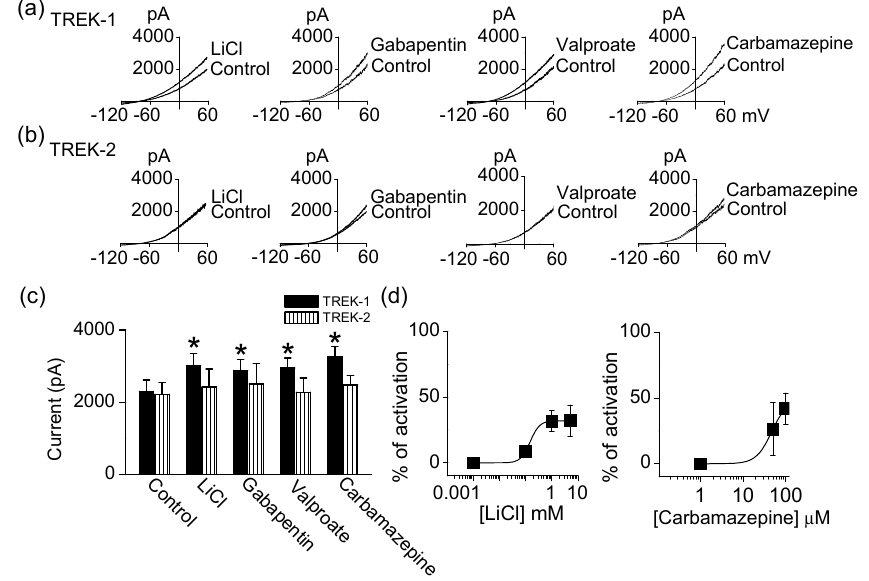
Figure 2. Comparison of effect of mood stabilizers on TREK-1 and TREK-2 current. ( a ) Effect of LiCl, gabapentin, valproate, and carbamazepine on TREK-1; ( b ) No effect of LiCl, gabapentin, valproate, and carbamazepine on TREK-2 activity; ( c ) Summary of effect of LiCl, gabapentin, valproate, and carbamazepine on TREK currents. Each bar is the mean ± SD of five experiments. Asterisk (*) indicates a significant difference against the control without application of drugs ( p < 0.05); ( d ) Dose-dependent effect of LiCl and carbamazepine on TREK-1 channel. The activation of TREK-1 current by increasing concentrations of LiCl (0.001 to 1 mM) and carbamazepine (1 to 100 μ M).